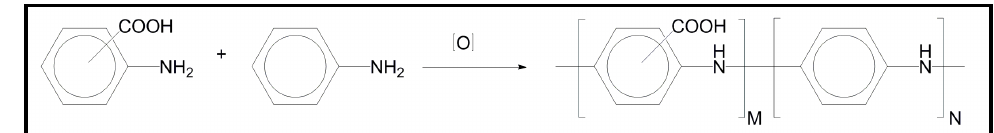
Figure 16. Chemical structure of copolymers constituted by anyline and aminobenzoic